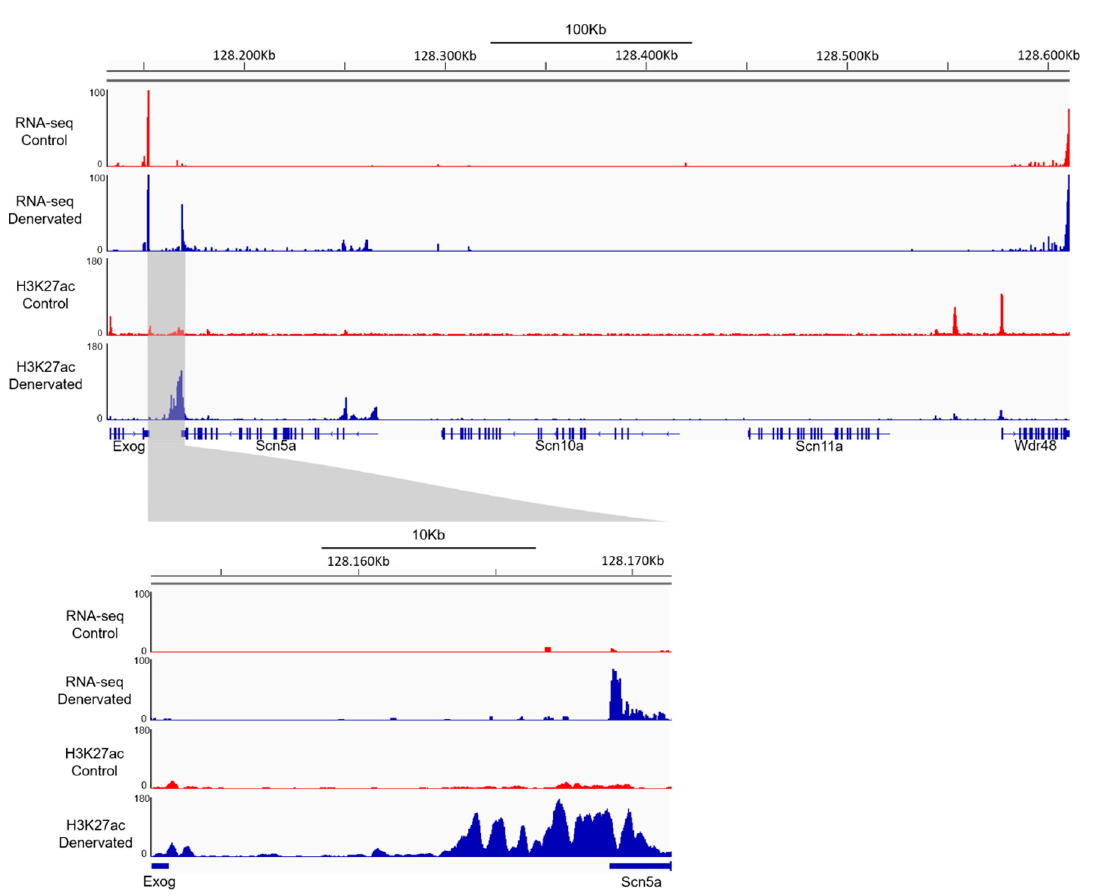
Figure 6. Denervation induces the activation of a super enhancer downstream of Scn5a . Integrative Genome Viewer (IGV) view of the H3K27ac distribution pattern in the Scn5a TAD and the reads of RNA-seq data in control and denervated gastrocnemius muscle samples. Expanded view of the super enhancer region located between Exog and Scn5a gene